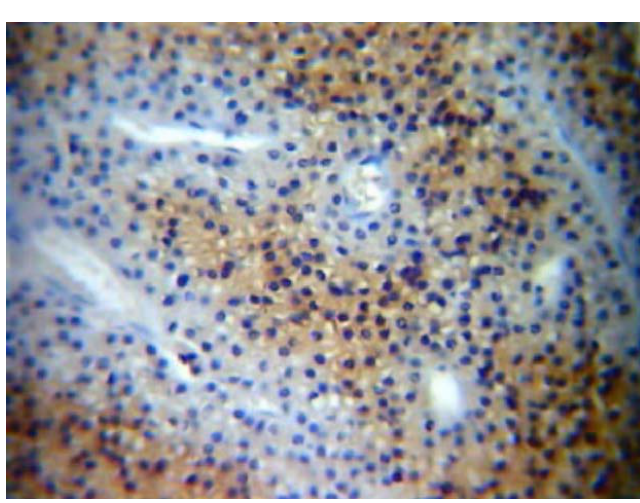
Fig. 7 Apoptosis marker (bcl-2 protein) in raw micrograph of a parathyroid